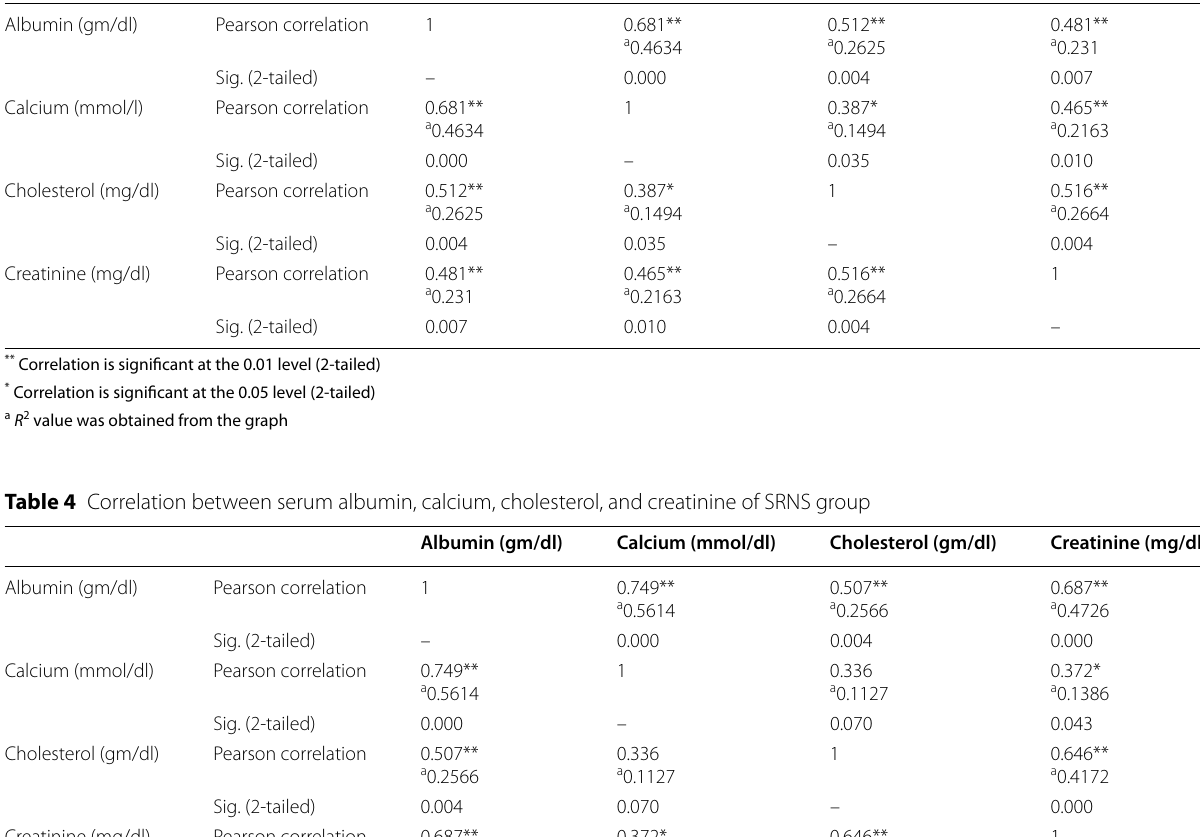
Table 3 Correlation between serum albumin, calcium, cholesterol, and creatinine of SSNS group